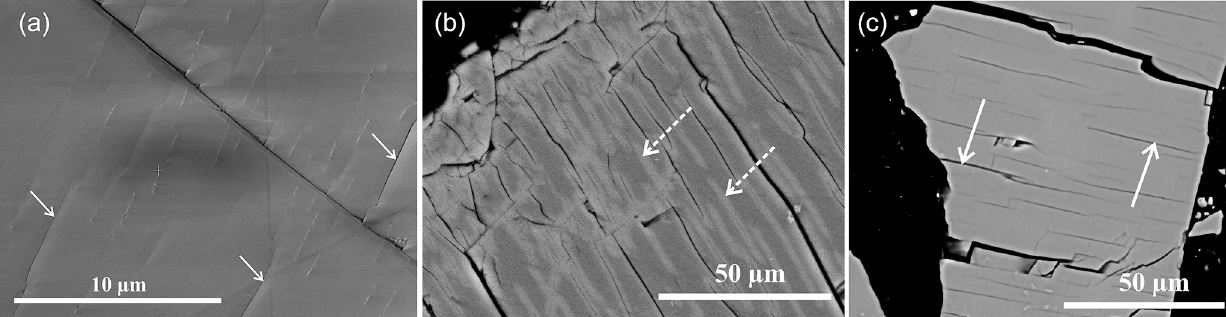
Figure 5. Backscattered electron (BSE) images of feldspar grains at different stages of the treatment. The arrows mark chemically induced cracks extending approximately parallel to the Murchison plane. (a) Surface of a sanidine grain after a compositional shift from c K = 0 . 84 to c K = 0 . 43 by cation exchange (cation-exchanged sample FS08-01). (b) Surface of a cation-exchanged sample after annealing at 550 ◦ C for 64d in contact with salt (open system setting, sample FS08-64o). The light grey bands (marked by the dashed arrows) are K-rich zones that are developed by reverse cation exchange along the cracks; dark areas correspond to the regions with higher concentration of Na. (c) Surface of cation-exchanged sample after annealing at 550 ◦ C in vacuum for 64d (closed system setting, sample FS08-64c). At the resolution of ESEM, this sample appears chemically homogeneous despite of the fact that the sample is exsolved forming a lamellar intergrowth with characteristic lamellar spacing of about 30nm (Petrishcheva et al., 2020). The relatively straight grain edge on the right follows a (010) cleavage